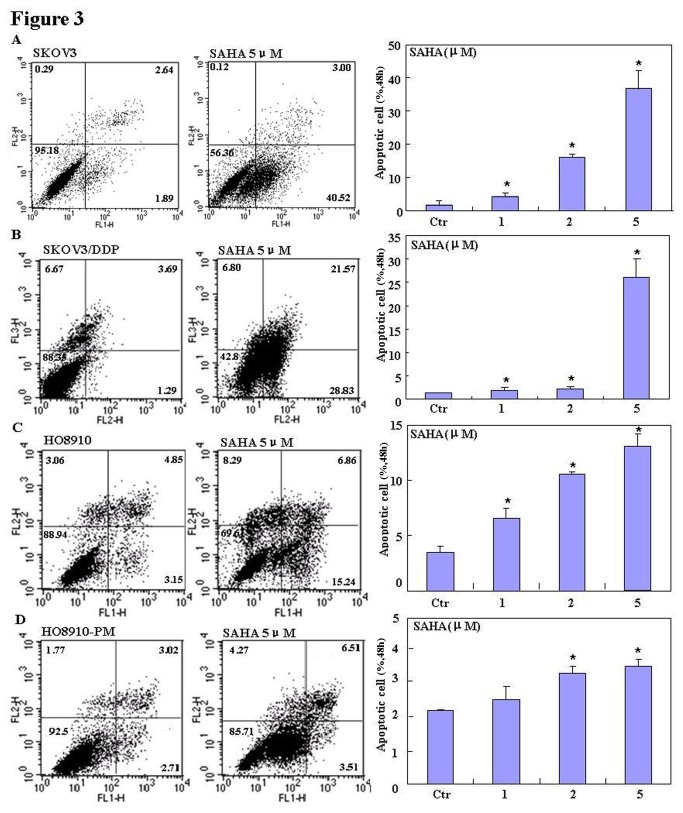
Effects of SAHA on apoptosis in ovarian carcinoma cells.Flow cytometric analyses(n=3) of ovarian cell-line pairs after Annexin IV staining showing that compared to negative controls, SAHA exposure results in higher levels of apoptosis in SKOV3 (A), SKOV3/DDP (B), HO8910 (C) and HO8910-PM (D) cells in a concentration-dependent manner.